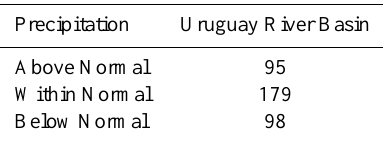
Table 1. Number of stations that showed precipitation above, within and below the